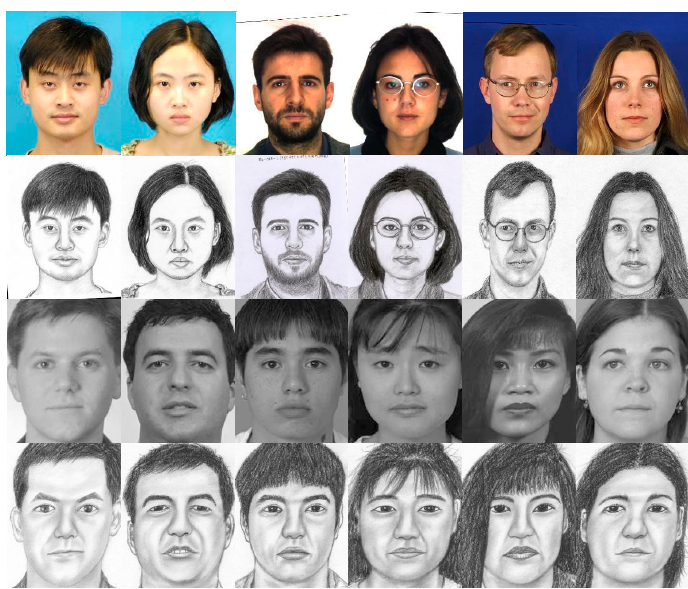
Figure 2. Example of face sketch-photo pairs in the CUFS dataset (first two rows) and the CUFSF dataset (last two rows). The first and the third row are face photos and the second and the last rows are corresponding face sketches drawn by the artist.